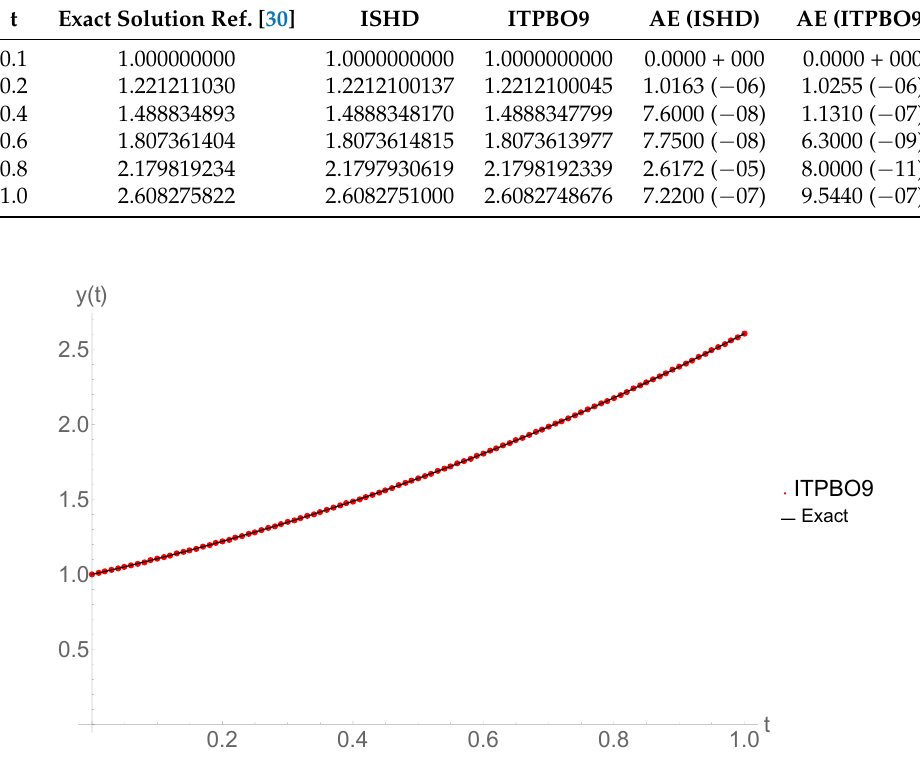
Figure 3. Response curve concerning Equation (27) with µ = 2, h =